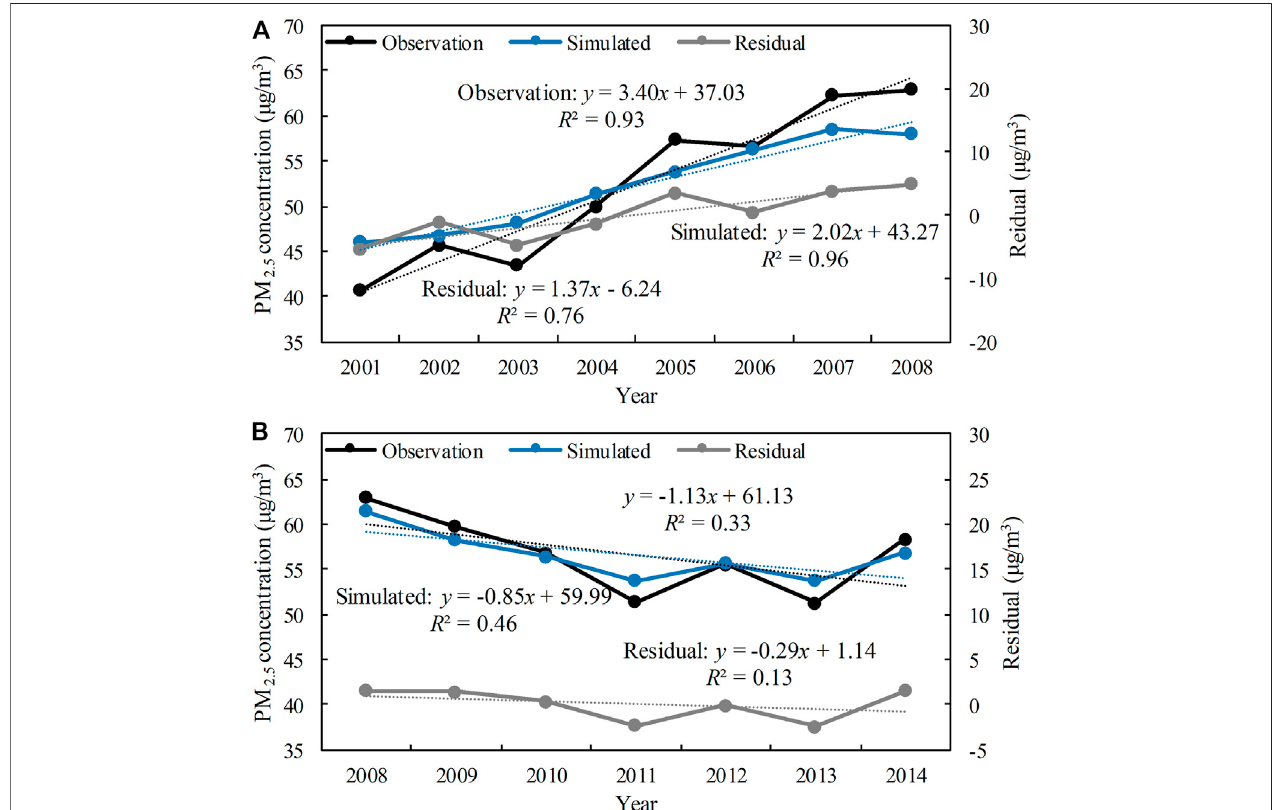
FIGURE 8 | Temporal trends of the observed, MLR simulated, and residual PM 2.5 concentrations during the periods (A) 2001 – 2008 and (B) 2008 – 2014.